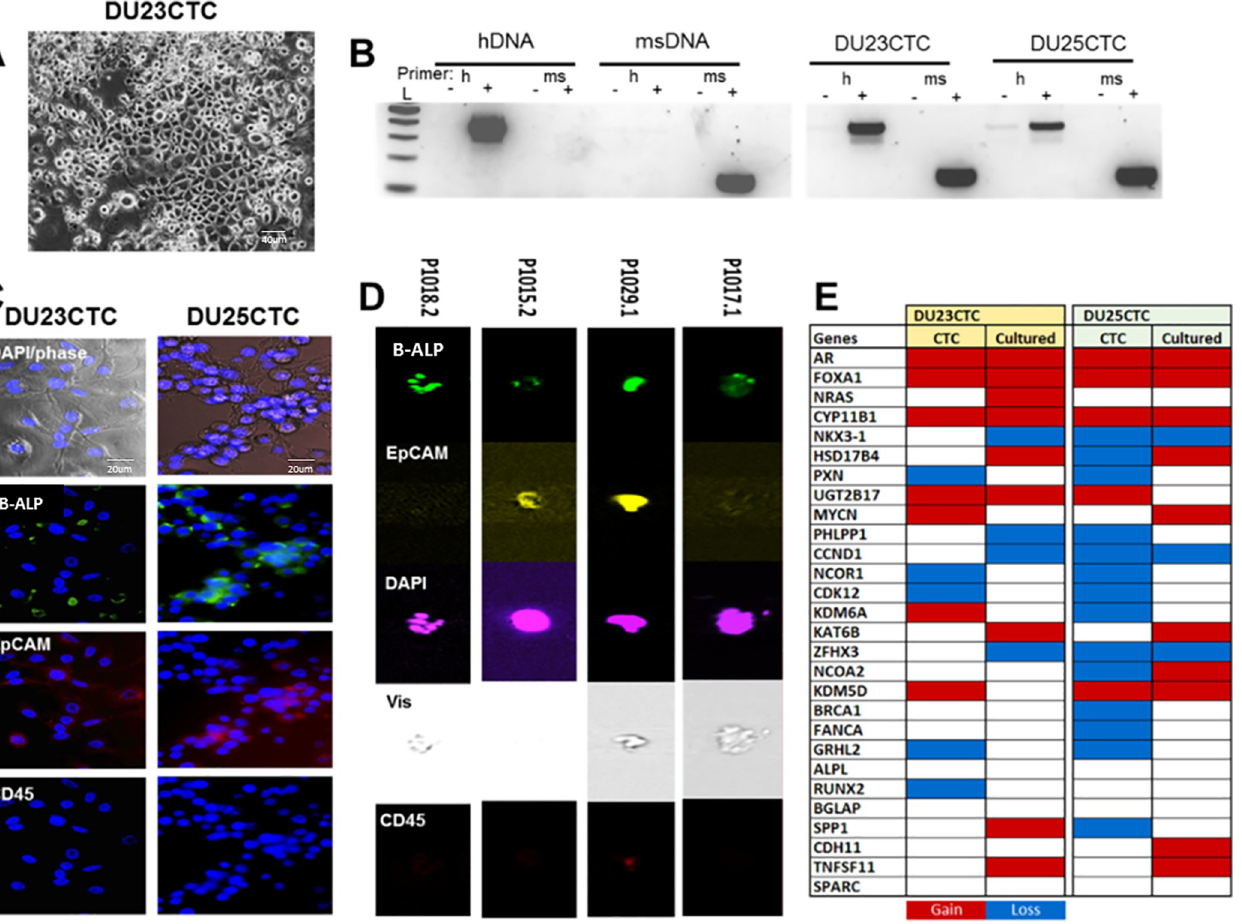
Fig 5. CTC low-passage cultures express ALPL and have common prostate cancer genetic alterations. A. Low passage CTC cultures display epithelial-like cobblestone morphology. B. A PCR-based assay for human and mouse DNA confirmed the presence of human DNA in the cultures. Human and mouse- specific positive and negative control DNAs (hDNA and msDNA) are shown on the left. L: 2 log ladder; h: human-specific primers; ms: mouse-specific primers. C. Immunofluorescence revealed ALPL expression, weak to moderate EpCAM, and no CD45 expression in CTC cultures. D. ImageStream analysis of ALPL/ALPL expression in CTCs. E. Array competitive genomic hybridization identified copy alterations in mutliple prostate cancer drivers in CTCs and cultures.